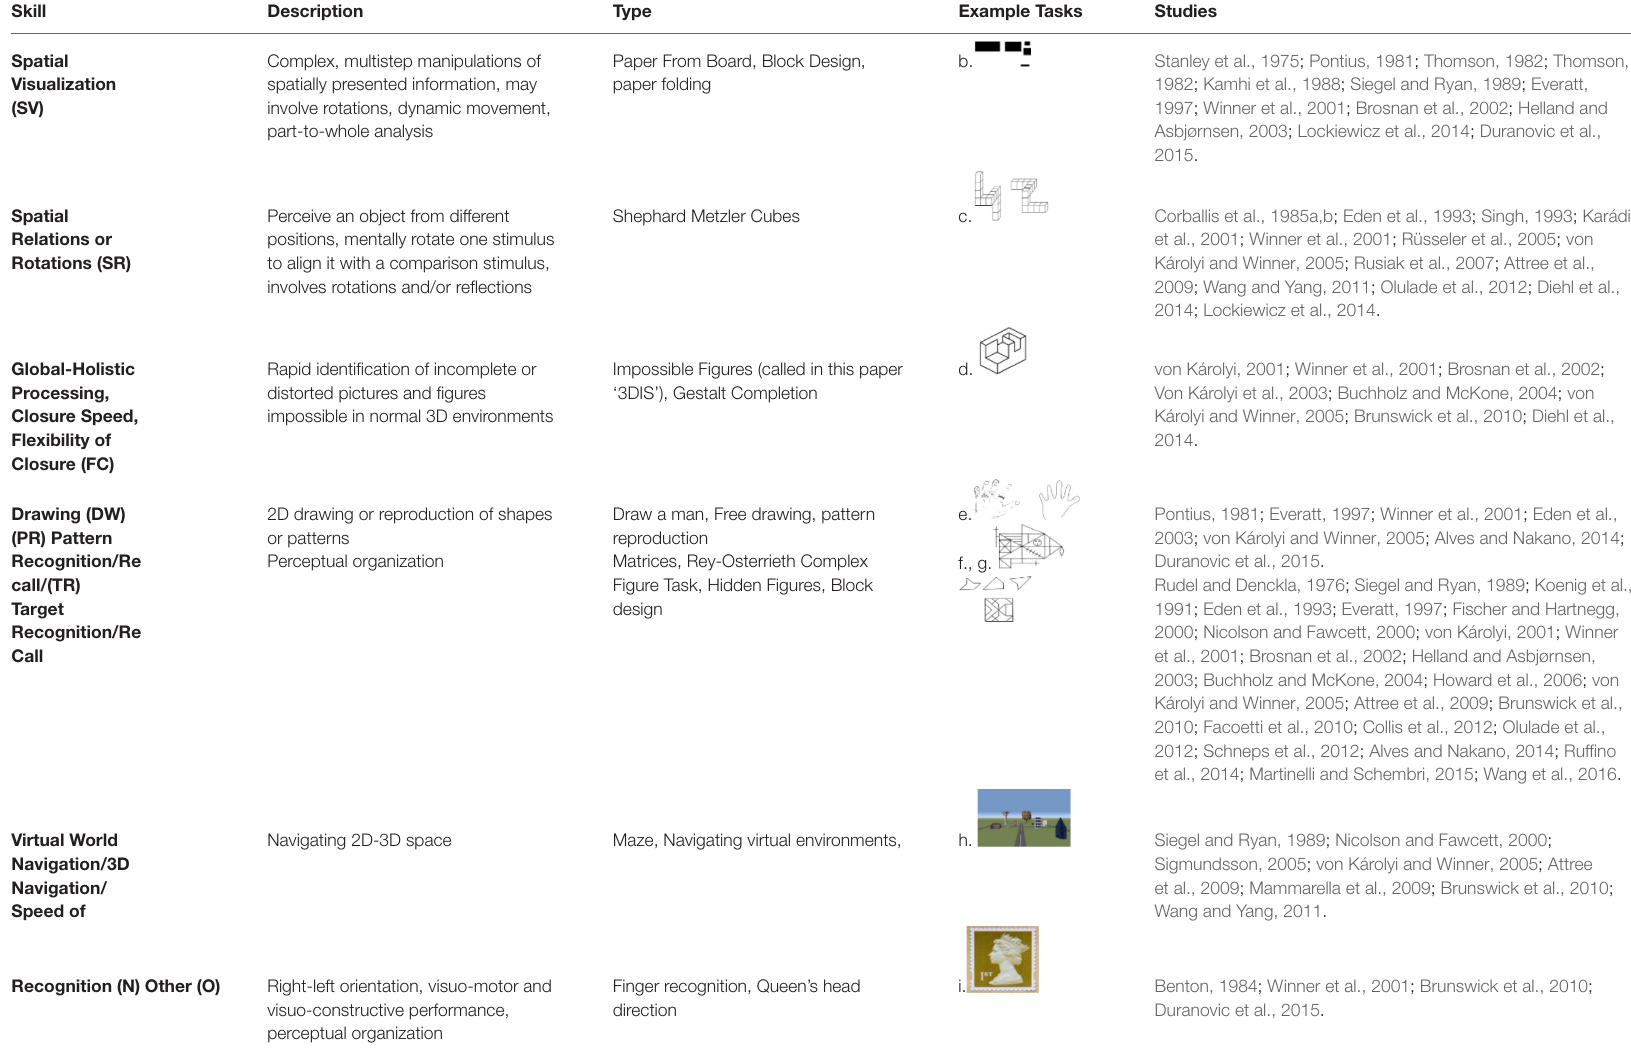
TABLE 1 | Summary of Trebeau-Crogman (2018) literature review on NLB tasks tested in the last 40 years of literature. Skill